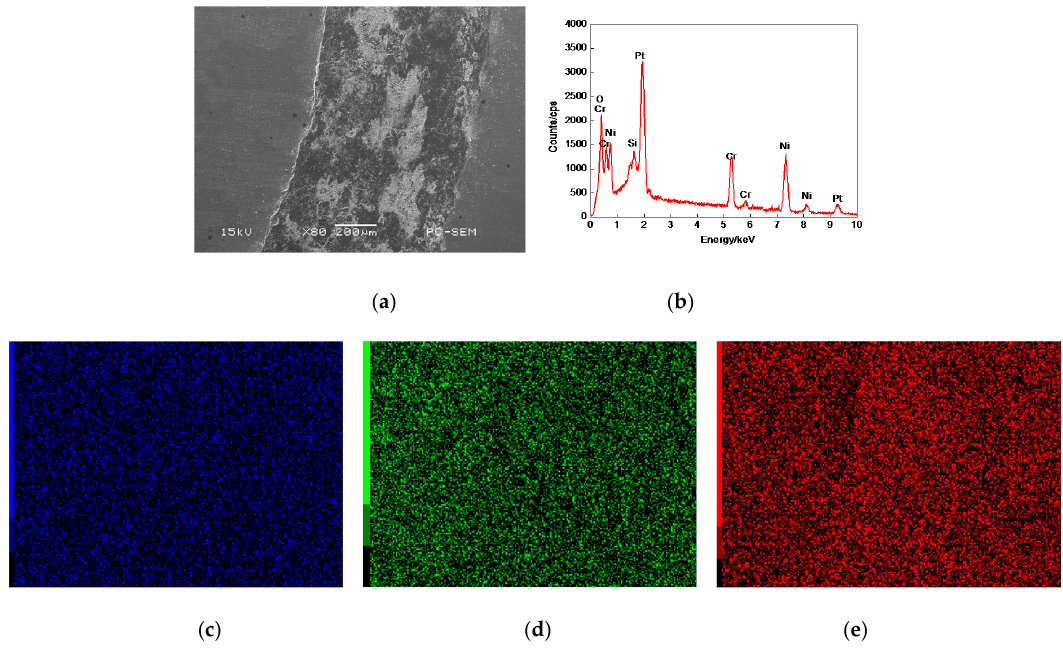
Figure 17. Plane scan analysis of worn track on 20% Cr–80% Ni coating. ( a ) Plane scanned position; ( b ) Plane scan analysis of worn track on 20% Cr–80% Ni coating; ( c ) Distribution of Cr content; ( d ) Distribution of Ni content; ( e ) Distribution of O content.